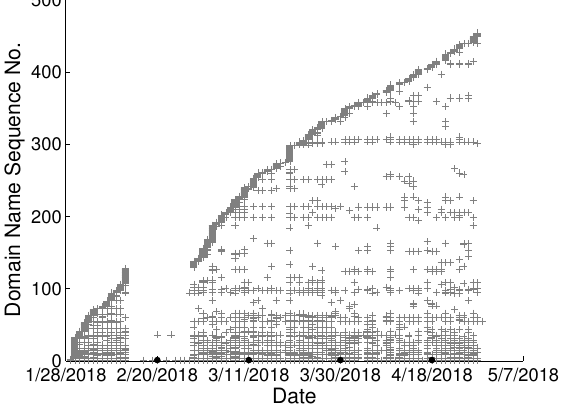
Figure 2. Domain names visited in chronological order from user A in our